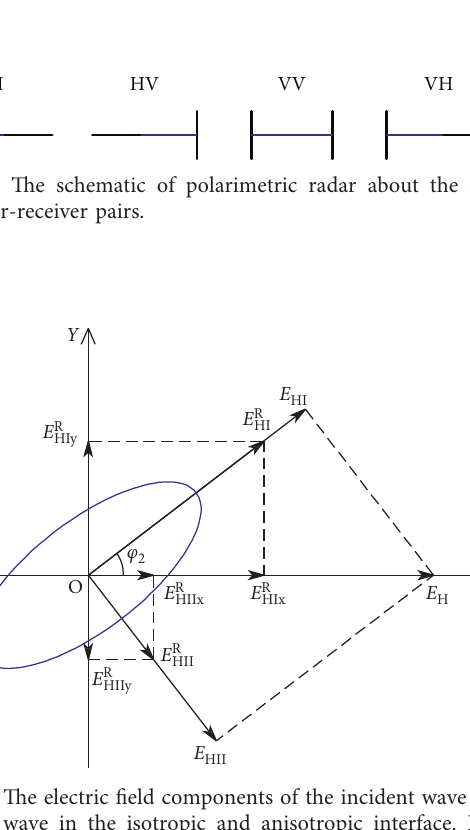
− φ � 0 and φ − φ � − π /6, respectively. The measurement 2 1 2 1